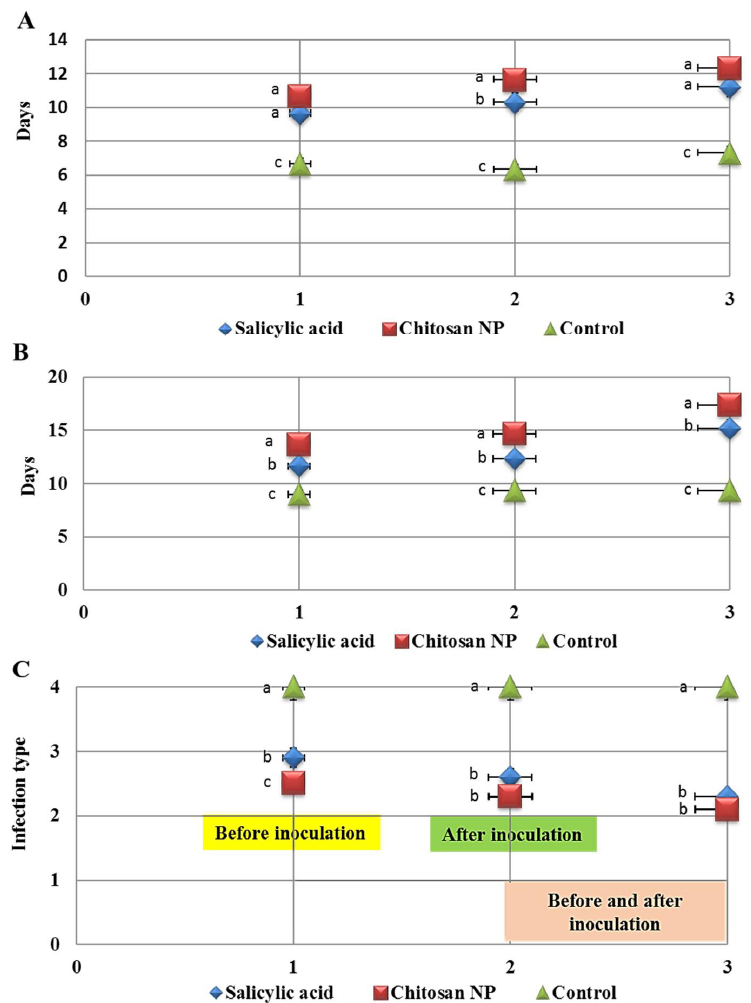
Figure 2. Effect of salicylic acid and chitosan nanoparticles application methods (1 = spray before inoculation by 24 h, 2 = spray after inoculation by 24 h and 3 = spray before and after inoculation by 24 h) on incubation period ( A ), latent periods ( B ) and infection type ( C ) of wheat leaf rust disease. The letters (a, b and c) denote significant difference.